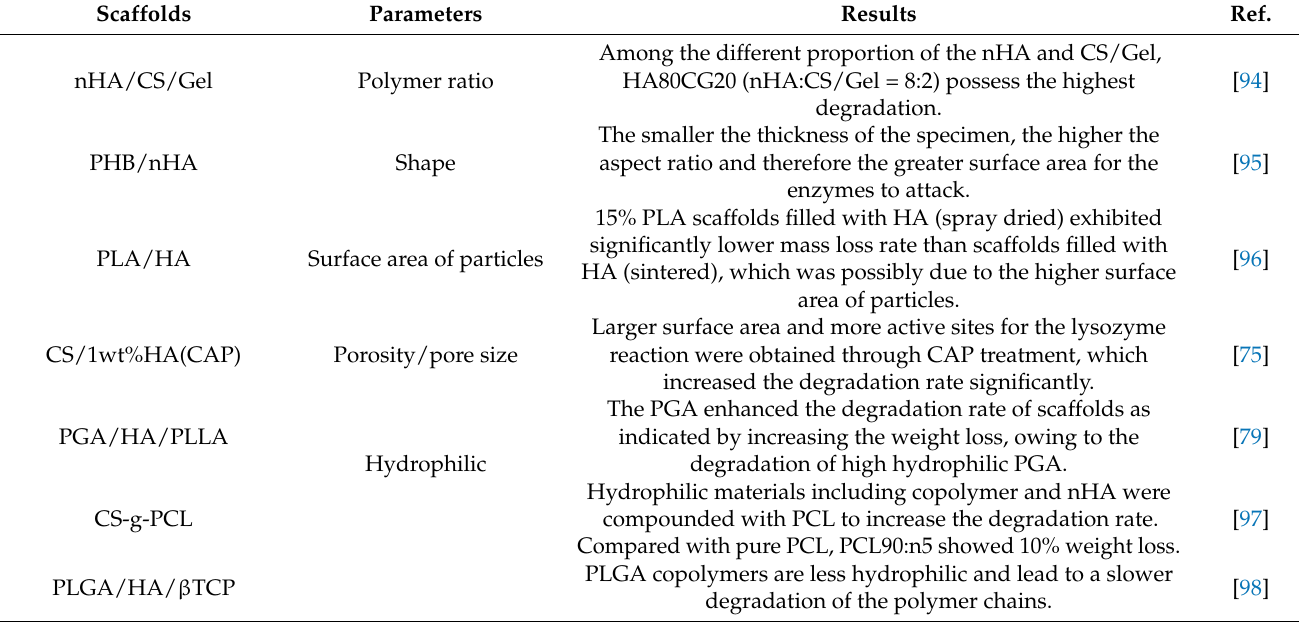
Table 2. Factors influencing the degradation of